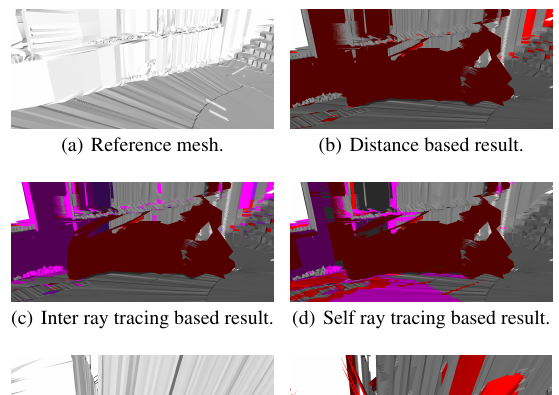
(c) Inter ray tracing based result. (d) Self ray tracing based result.